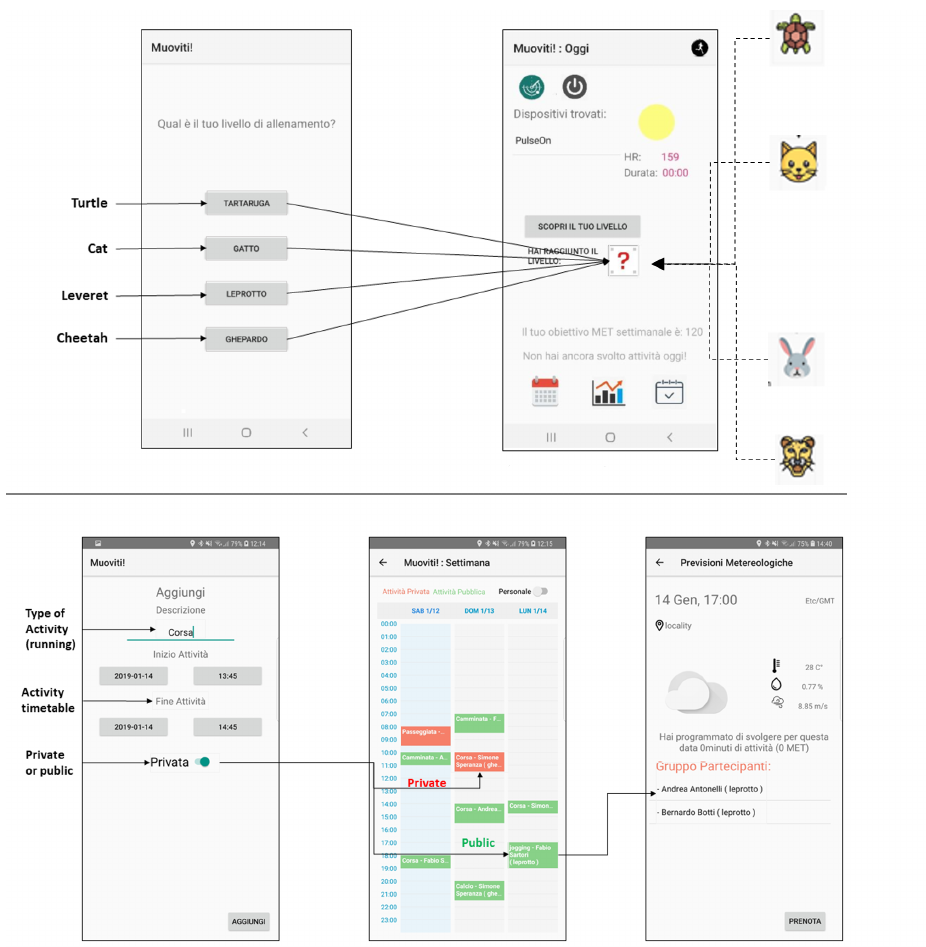
Figure 4. On the top , the GUI for self and automatic assessment of user profile; on the bottom , the calendar function developed in